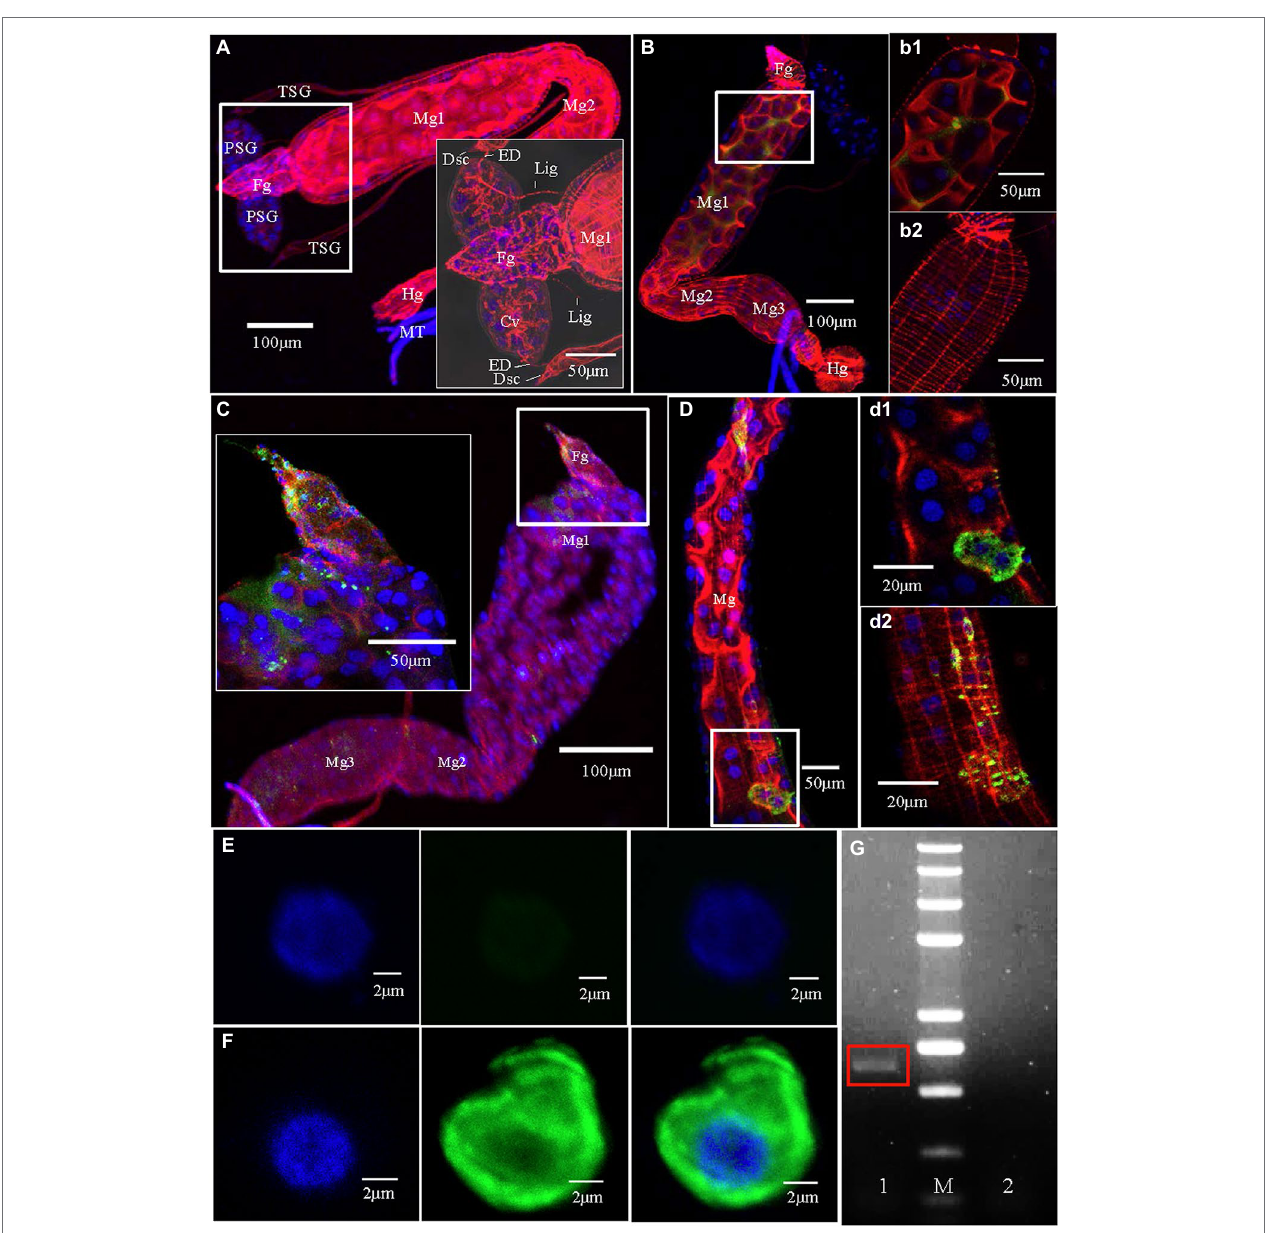
FIGURE 1 | Tomato zonate spot virus (TZSV) infection routes in the body of Frankliniella occidentalis . Samples were immunolabeled with the actin dye phalloidin- rhodamine (red), the nuclear dye DAPI (blue), and the nucleocapsid protein of TZSV (TZSV-N) conjugated to fluorescein isothiocyanate (green) and observed under a confocal laser scanning microscope. (A) The digestive system of a second-instar nymph fed with healthy pepper leaves. The boxed area shows the morphological characteristics of the upper portion of the digestive system. (B) At 1 h post-first access to diseased plants (padp), TZSV initially entered the gut lumen; (b1) and (b2) are enlargements of the boxed areas in (B) and show the presence of TZSV in the midgut lumen (b1) but not in muscle tissues (b2). (C) At 4 h padp, a small amount of TZSV immediately entered the epithelial cells of the foregut and the anterior portion of the midgut; the enlarged boxed area shows TZSV location in greater detail. (D) At 24 h padp, intense TZSV-N fluorescent signal was observed in the epithelial cells (d1) and the epitheliomuscular cells (d2) of the midgut. (E) A series of images showing a hemocyte of F. occidentalis fed with healthy pepper leaves; scale bars, 2 μ m. (F) Detection of the distribution of TZSV-N in the hemocyte of an infected F. occidentalis at 72 h padp. (G) Agarose gel electrophoresis of the RT-PCR product of the TZSV-N-encoding gene in F. occidentalis hemolymph. Lane 1, TZSV- infected F. occidentalis ; M, 2-kb DNA ladder; lane 2, uninfected F. occidentalis